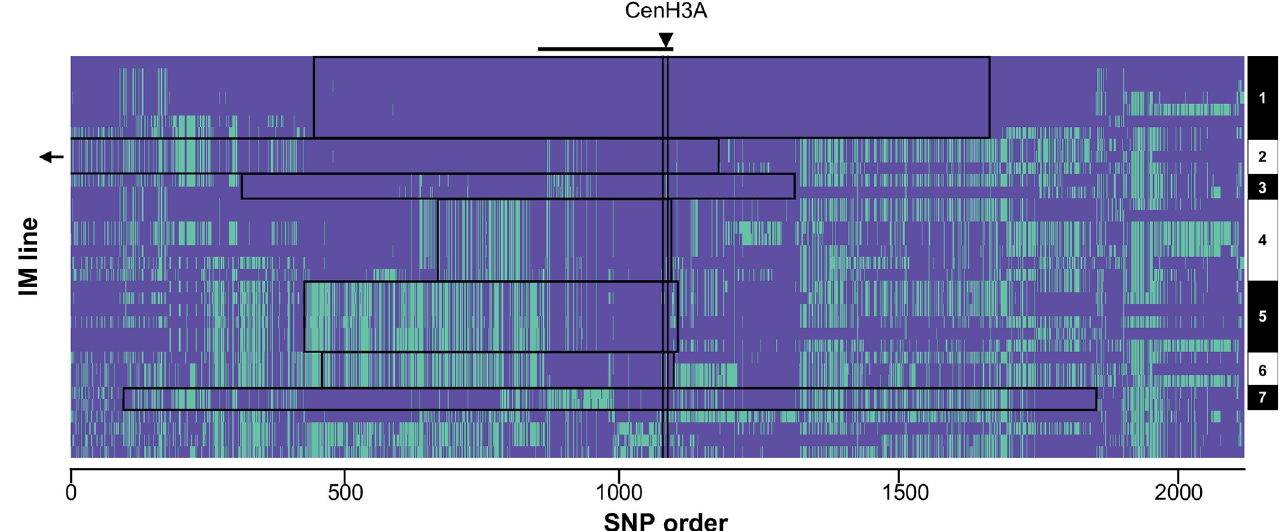
Fig 4. CenH3A exhibits a recent selective sweep, consistent with evolution in response to costly D spread. Exonic single nucleotide polymorphisms (SNPs) across a 496 kilobase (kb) region flanking CenH3A (13.5–14 Mb on Chromosome 14) are displayed for each of 34 lines from the Iron Mountain population of M . guttatus . The ~2000 SNPs are ordered by genomic position, but the x-axis is not scaled to physical or genetic distance. SNPs are coded according to whether they match (purple) or differ from (green) the haplotype of IM1054, which bears one of the most common CenH3A-flanking haplotypes. The arrowhead and horizontal line mark the location of CenH3A. The seven haplotypes (1–7) were assigned manually and are outlined in black boxes. For visual resolution around CenH3A, the longest haplotype ( > 620kb) was truncated. Haplotype details are given in S6